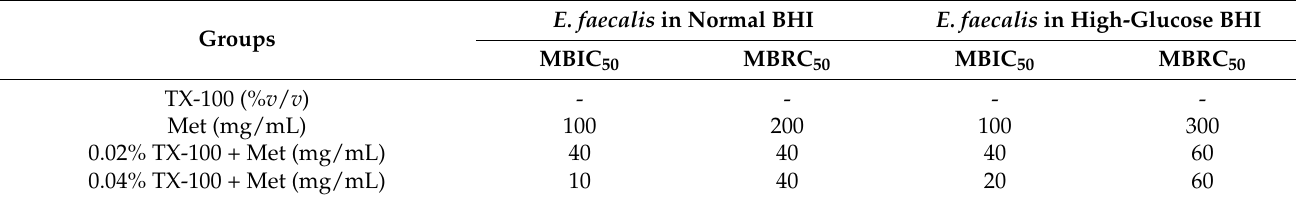
Table 3. The antibiofilm activities of TX-100 and Met with or without TX-100 against E. faecalis in normal and high-glucose BHI.